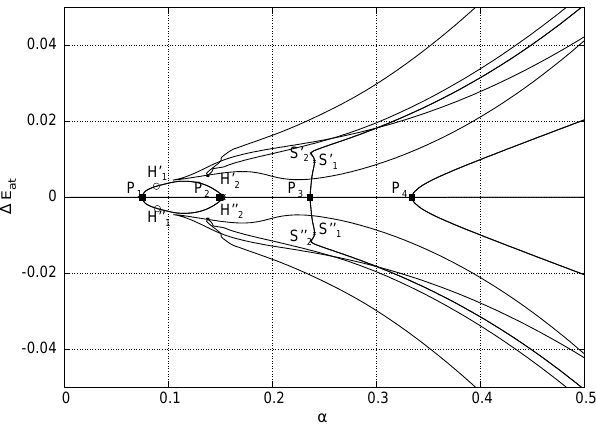
Fig. 11: Bifurcation diagram for the atmospheric equilibria at σ =0 . 67 ; to be compared with the Fig. 11. Bifurcation diagram for the atmospheric equilibria at one obtained at σ =0 . 65 and shown in Fig. 5. The small crosses mark the position of saddle-node σ = 0 . 67; to be compared with the one obtained at σ = 0 . 65 and bifurcations; P 1 and P 3 aresupercriticalpitchforkbifurcations,while P 2 and P 4 aresubcriticalones. shown in Fig. 5c. The small crosses mark the position of saddle- The SST forcing is similar to Fig. 3c. node bifurcations; P 1 and P 3 are supercritical pitchfork bifurca- tions, while P 2 and P 4 are subcritical ones. The SST forcing is similar to Fig.